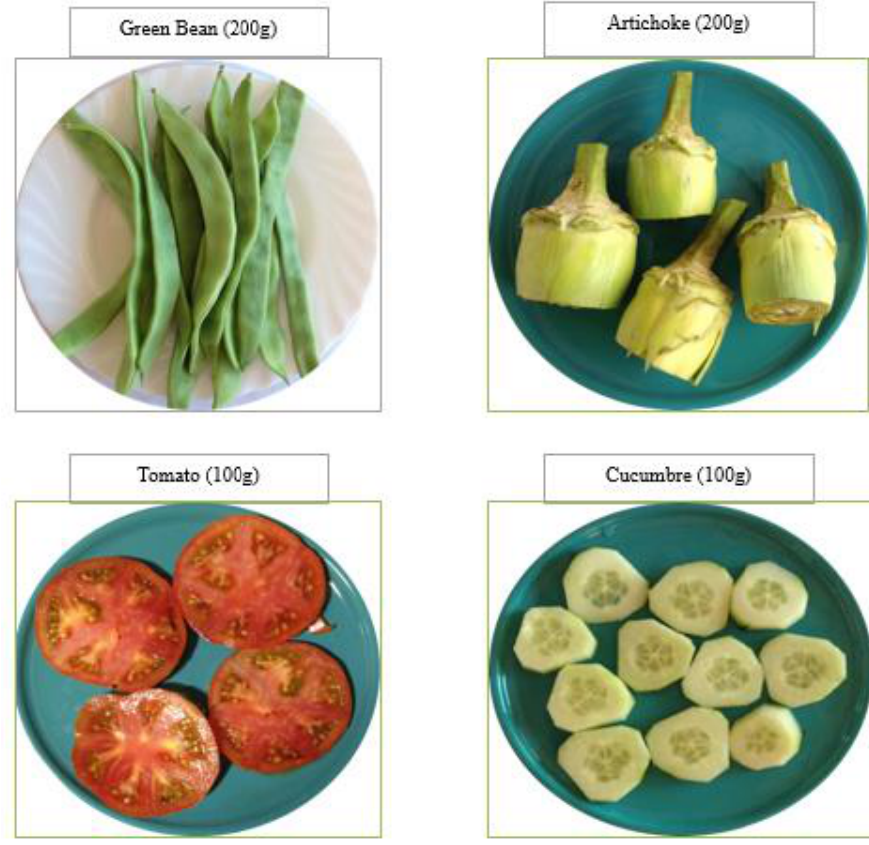
Figure 1. Example of the photo album.